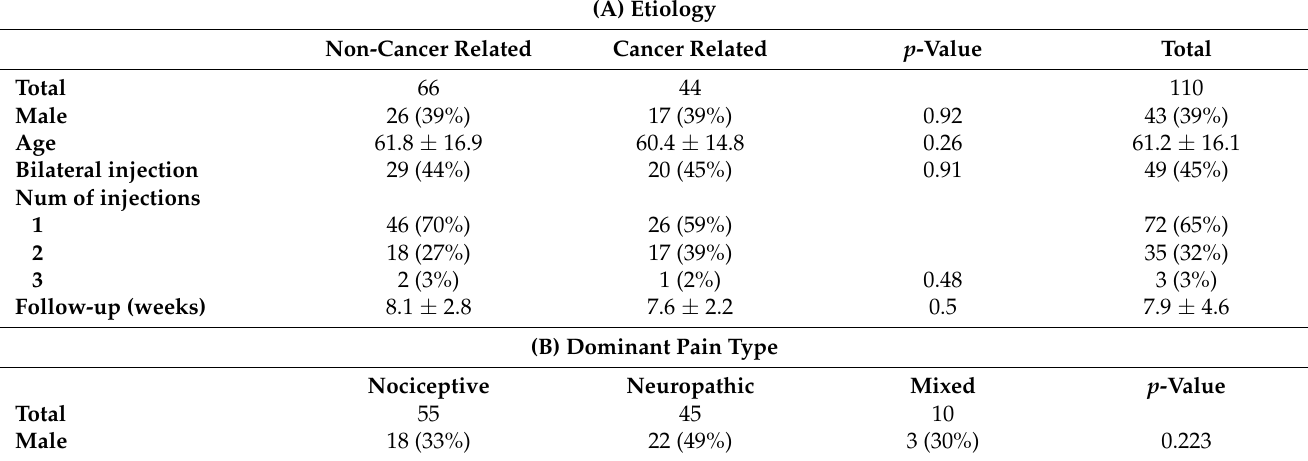
Table 1. Demographic and preprocedural